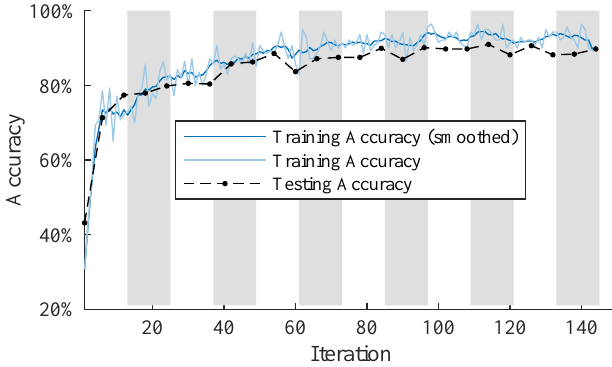
Figure 5. Training progress plot of the convolutional neural network.